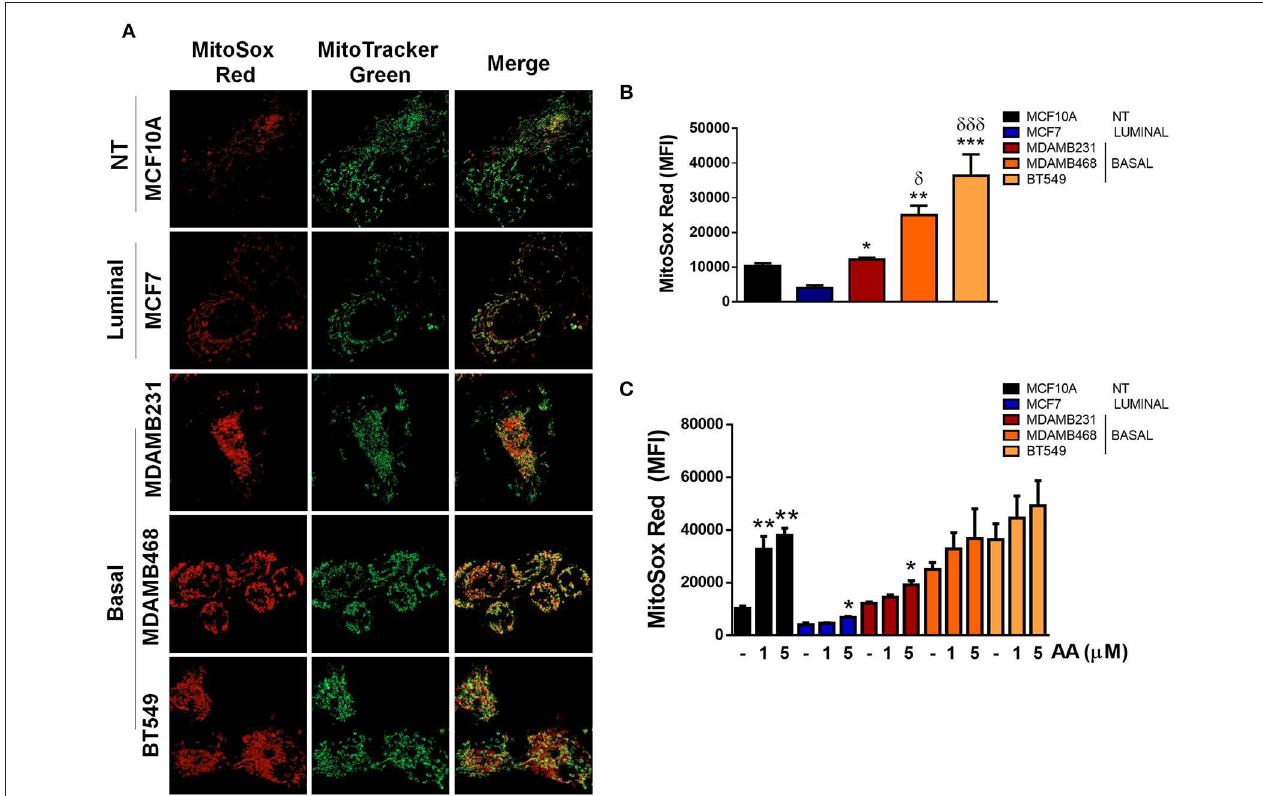
FIGURE 5 | ROS in basal, TNBC cell lines are derived from the mitochondria. (A) Mitochondria were stained with Mitotracker (green) and MitoSox (red) to evaluate production of mitochondrial ROS. (B) Quantification of MitoSox fluorescence was performed by flow cytometry in basal conditions or (C) in cells treated with Antimycin A (AA) at the indicated concentrations. Graphs show mean ± SEM of 3 independent experiments. In (B) *different to MCF7 and δ different to MCF10A. In (C) *different to control. * p < 0.05; ** p < 0.01; *** p < 0.001; * δ < 0.05; and *** δδδ < 0.001.